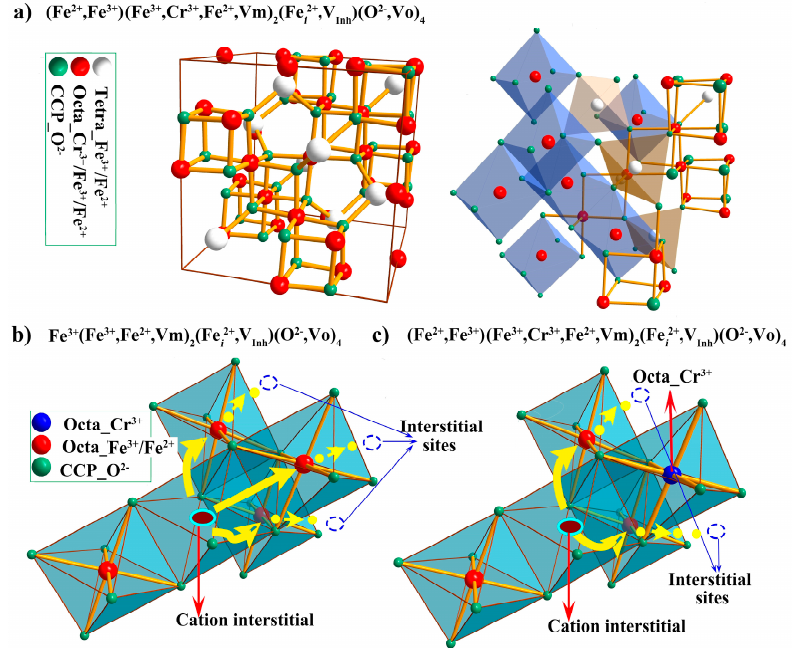
Figure 6. Schematics of ( a ) elemental distribution in a spinel Fe(Fe,Cr) 2 O 4 cell and diffusion paths for cation interstitials within ( b ) magnetite and ( c ) Fe 3 − x Cr x O 4 (some Cr 3+ replacing Fe 3+ in octahedral sites of magnetite). Note: In (Fe 3+ ,Fe 2+ )(Fe 3+ ,Cr 3+ , Fe 2+ ,Vm) 2 (Fe i 2+ ,V Inh )(O 2 − ,Vo) 4 , the four items, in turn, represent tetrahedral interstices, octahedral interstices, extra octahedral interstices which are inherently vacant (V Inh ) for the stoichiometric composition, and oxygen sublattices, respectively. The inner and outer layers of oxide scales formed on F-M steels in SCW generally comprise Fe- Cr spinel (Fe 3 − x Cr x O 4 ) and magnetite, respectively, which all can be described as face-centered cubic, close-packed sublattices of n oxygen ions with one eighth of the total of 2n sites having tetrahedral coordination occupied by Fe 3+ and Fe 2+ , and the half of the n octahedral coordination filled with cations (Fe 3+ , Fe 2+ ,and/or Cr 3+ ) [45,46]. At lower temperatures (less than 400 °C), magnetite has a unit cell of 32 O 2 − ions into which are placed 8 Fe 3+ ions at tetrahedral sites and 8 Fe 2+ + 8 Fe 3+ ions at octahedral interstices (i.e., inverse spinel structure), while a certain proportion of Fe 2+ goes into the tetrahedral interstices, more like a normal spinel, with an increase in temperature [46]. Generally speaking, the principal defects are cation vacancies and iron interstitials, which is the basic supporting theory for the off-stoichiometric structure, as well as for the metal transport within this bulk oxide, while the oxygen sublattice remains relatively fixed because its defects have higher energy [11,46–48]. However, for oxide formation at the metal/oxide interface, and noting that the oxide grows into the metal, which is correct for the growth of the inner layer, then oxygen vacancies are always produced at the metal/inner layer interface leading to the inward transport of oxide ions, and hence are always present in the barrier layer regardless of their energy [49,50]. Without displaying any defects and without distinguishing between the different cations on the same coordination sites for simplicity, Figure 6a presents a schematic of the elemental distribution (left) and some octahedral/tetrahedral sites (right) in a complete unit cell of the forming (Fe 3+ , Fe 2+ )(Fe 3+ ,Cr 3+ , Fe 2+ ,Vm) 2 (Fe i 2+ ,V Inh )(O 2 − ,Vo) 4 , recognizing that point defects are always present in a growing oxide. The chemical formula in Figure 6a, (Fe 3+ , Fe 2+ )(Fe 3+ ,Cr 3+ , Fe 2+ ,Vm) 2 (Fe i 2+ ,V Inh )(O 2 − ,Vo) 4 , shows both presence of cation vacancies (Vm), cation interstitials (Fe i 2+ ), and oxygen vacancies (Vo) for the growing Fe 3 − x Cr x O 4 phase. The first and second sublattices denote the tetrahedral and octahedral interstices, respectively, and the fourth the oxygen sublattice. The third item stands for